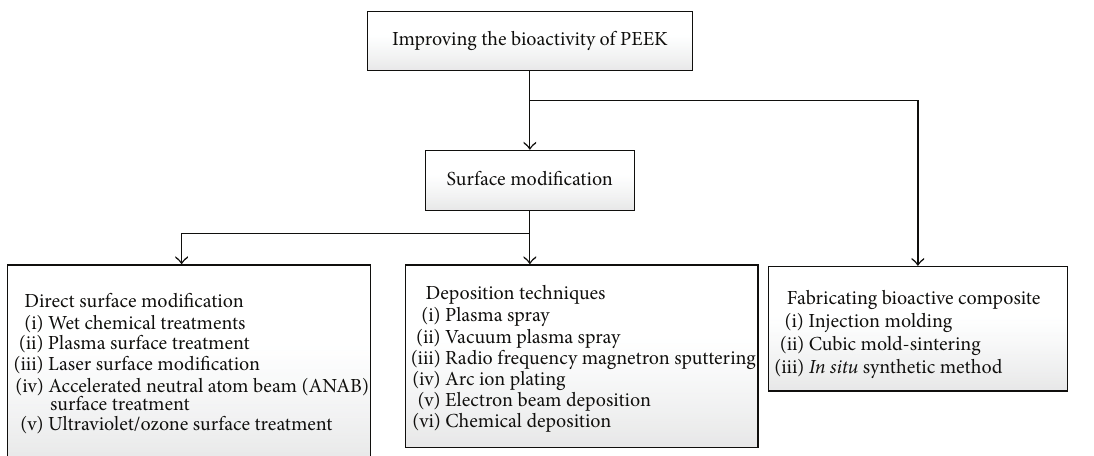
Figure 2: General categorization of the techniques for improving PEEK’s bioactivity.